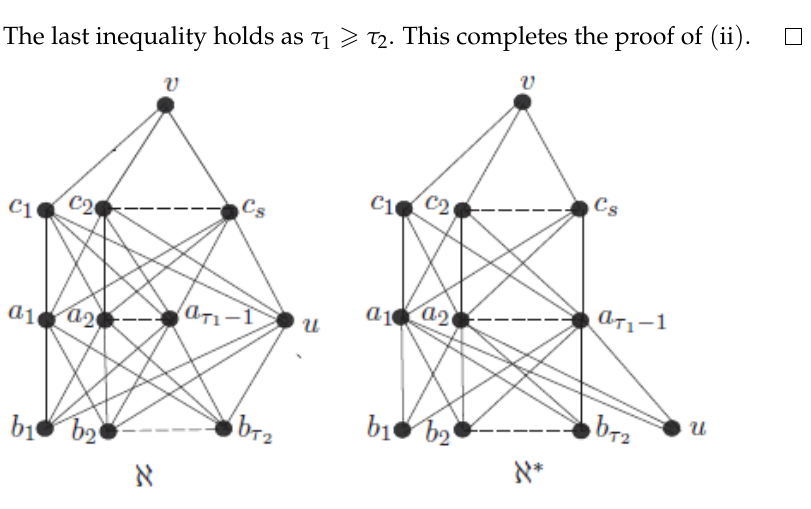
Figure 3. Networks ℵ and ℵ ∗